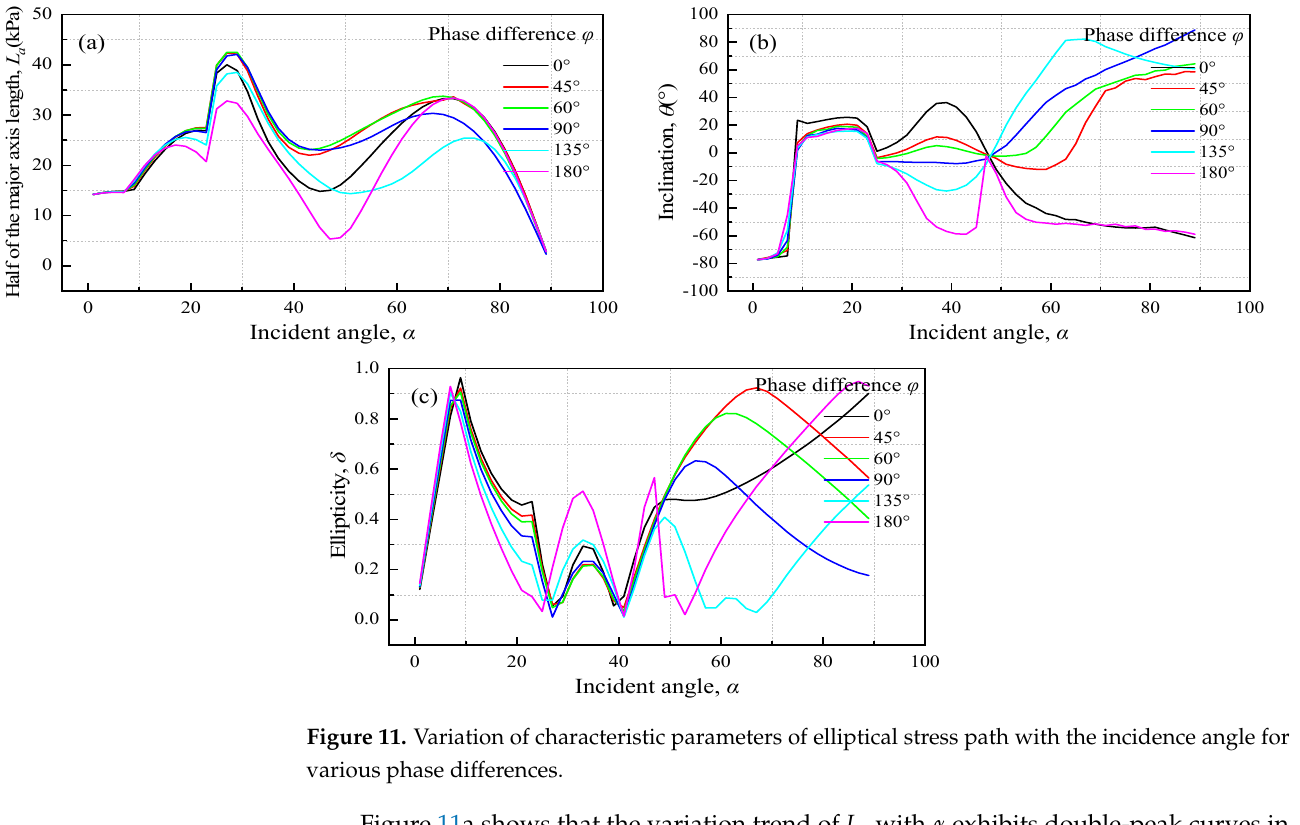
Figure 12. Variation of elliptical stress path with the incidence angle for various phase difference.